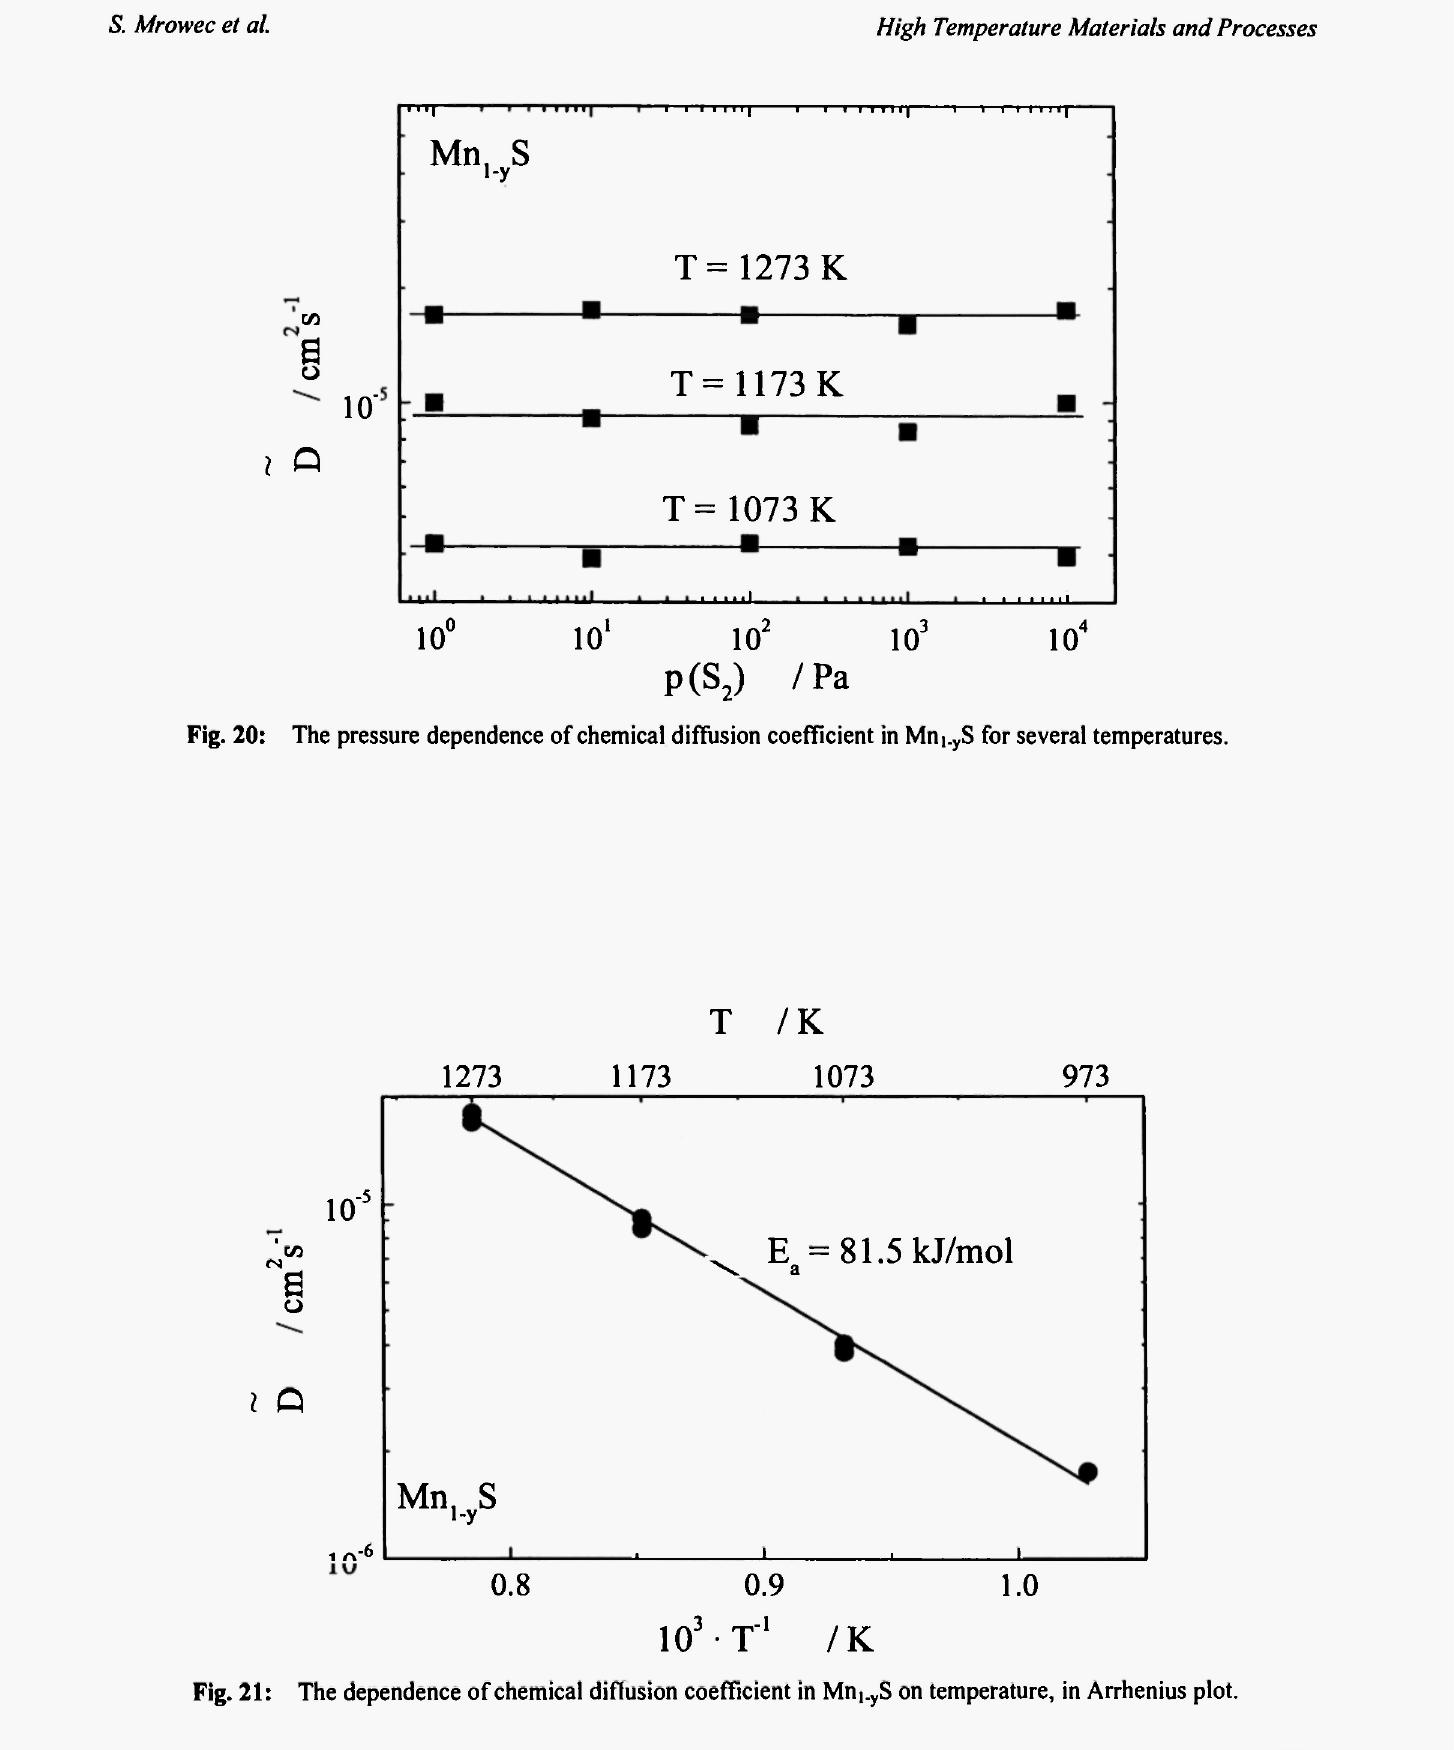
Fig. 21: The dependence of chemical diffusion coefficient in Mni. y S on temperature, in Arrhenius